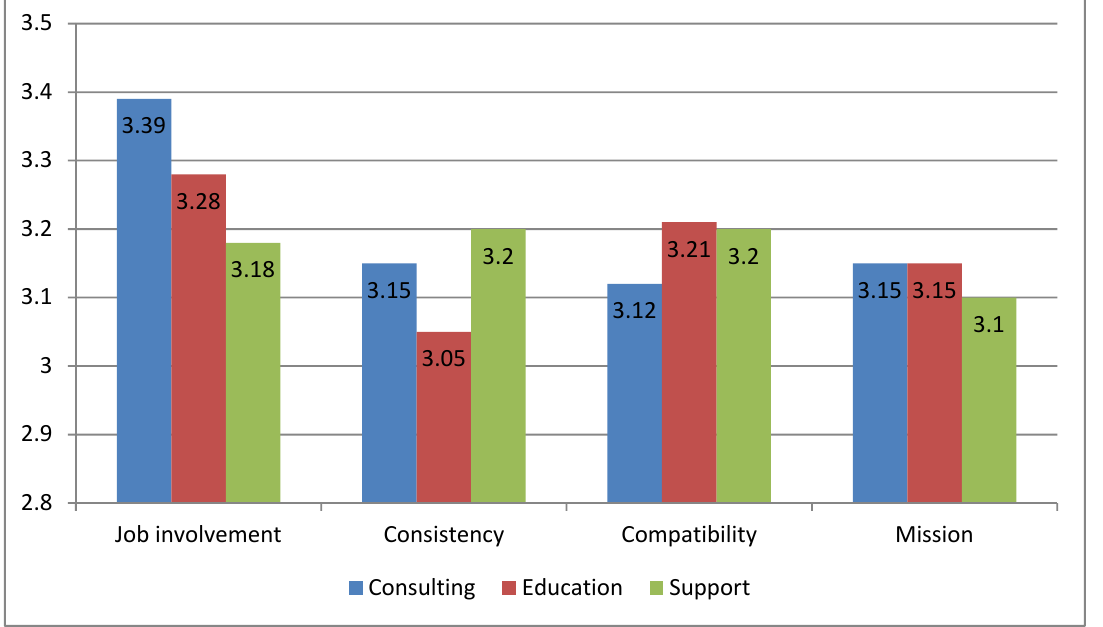
Fig. 2. Mean scores for different components of Denison